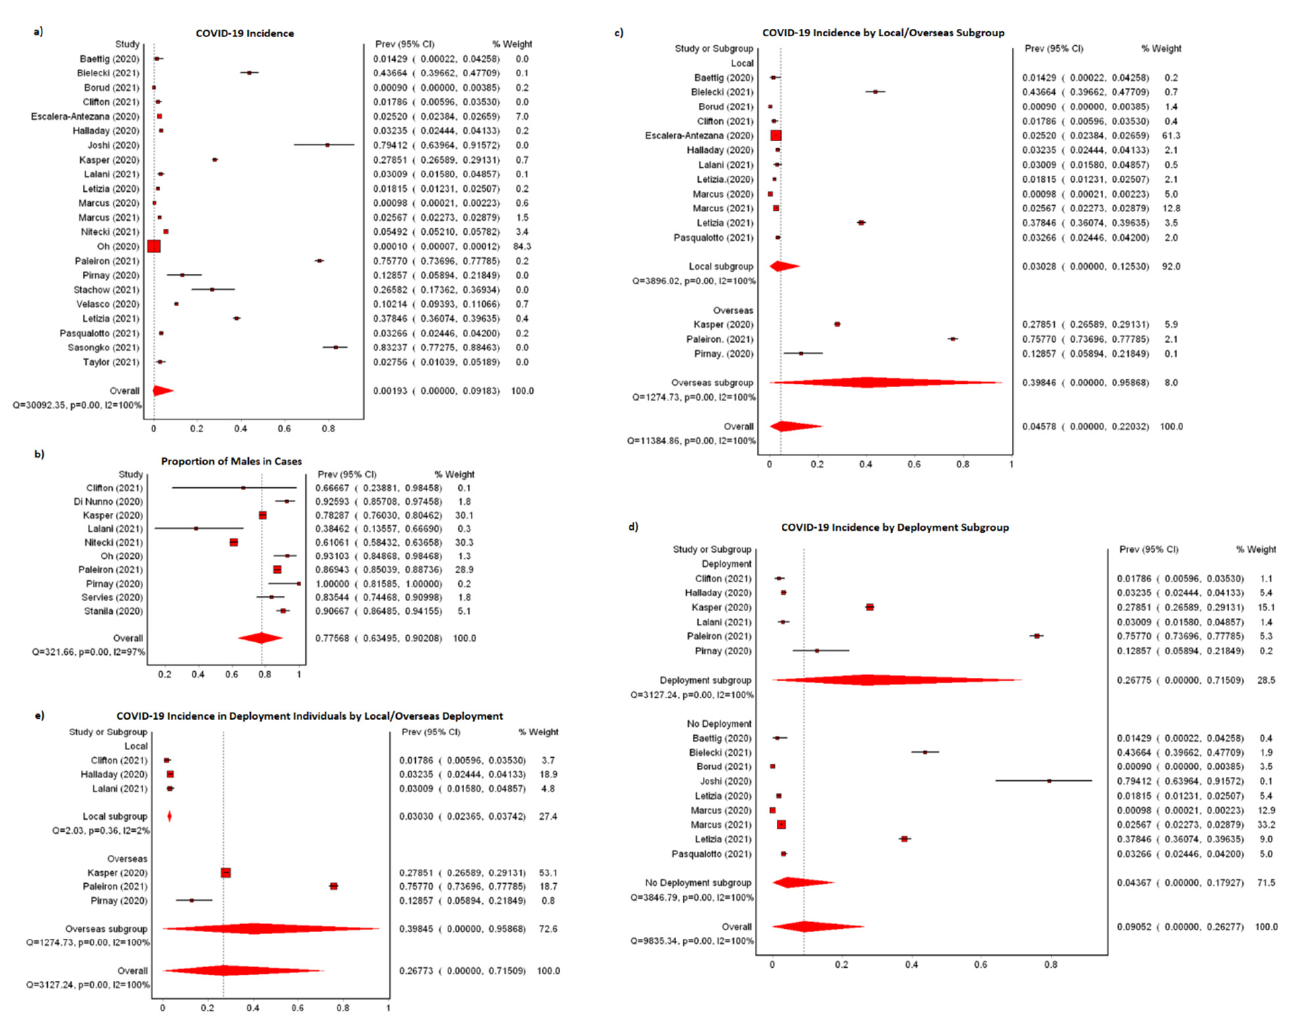
Figure 2. Meta-analyses of COVID-19 incidence ( a ) COVID-19 in military populations, ( b ) COVID-19 incidence by populations with possible exposure locally or overseas, ( c ) COVID-19 incidence by deployment, ( d ) COVID-19 incidence by local or overseas deployment, ( e ) males in cases (using maximum case numbers provided by studies that were not included in original study analysis).